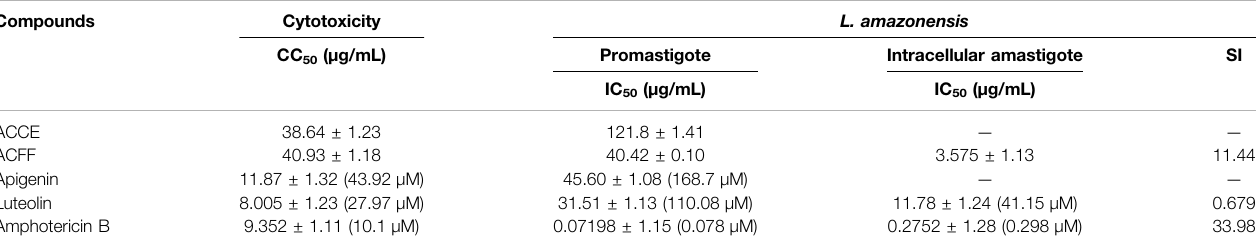
TABLE 3 | Cytotoxicity and antileishmanial activity of extracts and isolated fl avonoids from Arrabidaea chica . Compounds